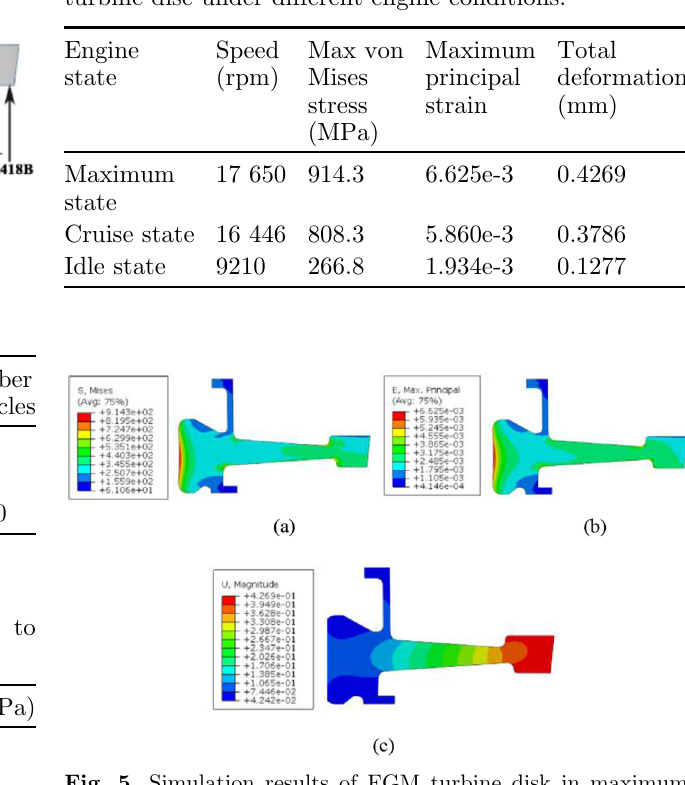
Fig. 5. Simulation results of FGM turbine disk in maximum state: (a) von Mises stress distribution nephogram, (b) strain distribution nephogram, and (c) deformation distribution